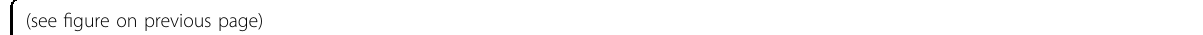
Fig. 3 The supernatant from ferroptotic cells increased cell death and decreased SA- β -gal in recipient cells. A – C After MEFs had been exposed to erastin for 24 h, the supernatant medium was exchanged (erastin was removed). After 3 h, the supernatant medium was collected and administered to recipient MEFs. A Experimental outline. B , C These are data of donor MEFs. B Optical microscope image. C Quanti fi cation of dead cells by fl ow cytometer. D , E These are the data of recipient MEFs. D Optical microscope image. E Quanti fi cation of dead cells and SA- β -gal-positive cells by fl ow cytometer. F – J α -Toc was added to the conditioned medium prepared as in A . F Experimental outline. G , H These are data of donor MEFs. G Optical microscope image. H Quanti fi cation of dead cells by fl ow cytometer. I , J These are the data of recipient MEFs. I Optical microscope image. J Quanti fi cation of dead cells and SA- β -gal-positive cells by fl ow cytometer. Scale bars in B , D , G , and I represent 100 µm. The box-and-whisker plots of C , E , H , and J show the 25th and 75th percentile quartiles and median values (center black line) and maximum and minimum values of the data. P value of C and H by two-sided t test. P value of E and J by Tukey ’ s test after two-way ANOVA.